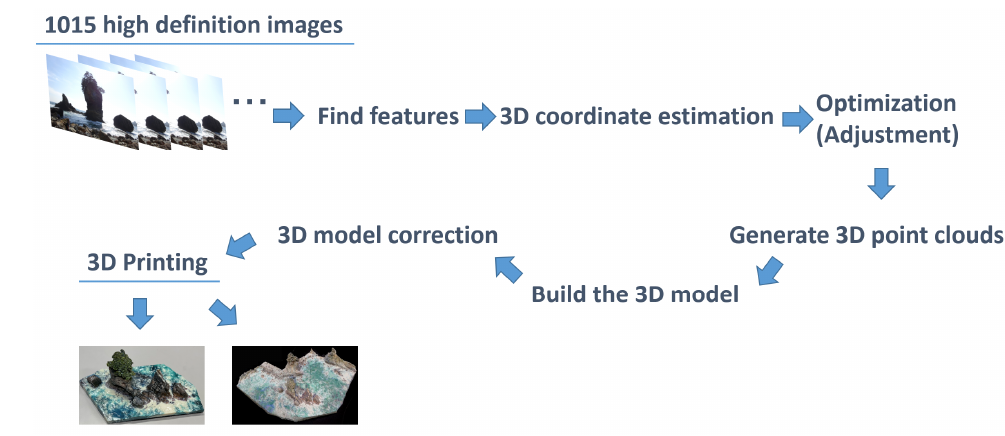
Figure 6. Overview of modeling Giant Coastal Rocks.